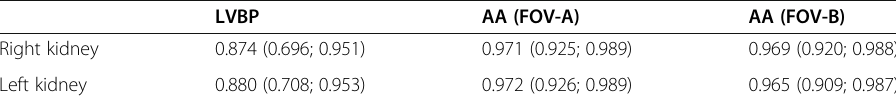
Table 4 Inter-observer variability